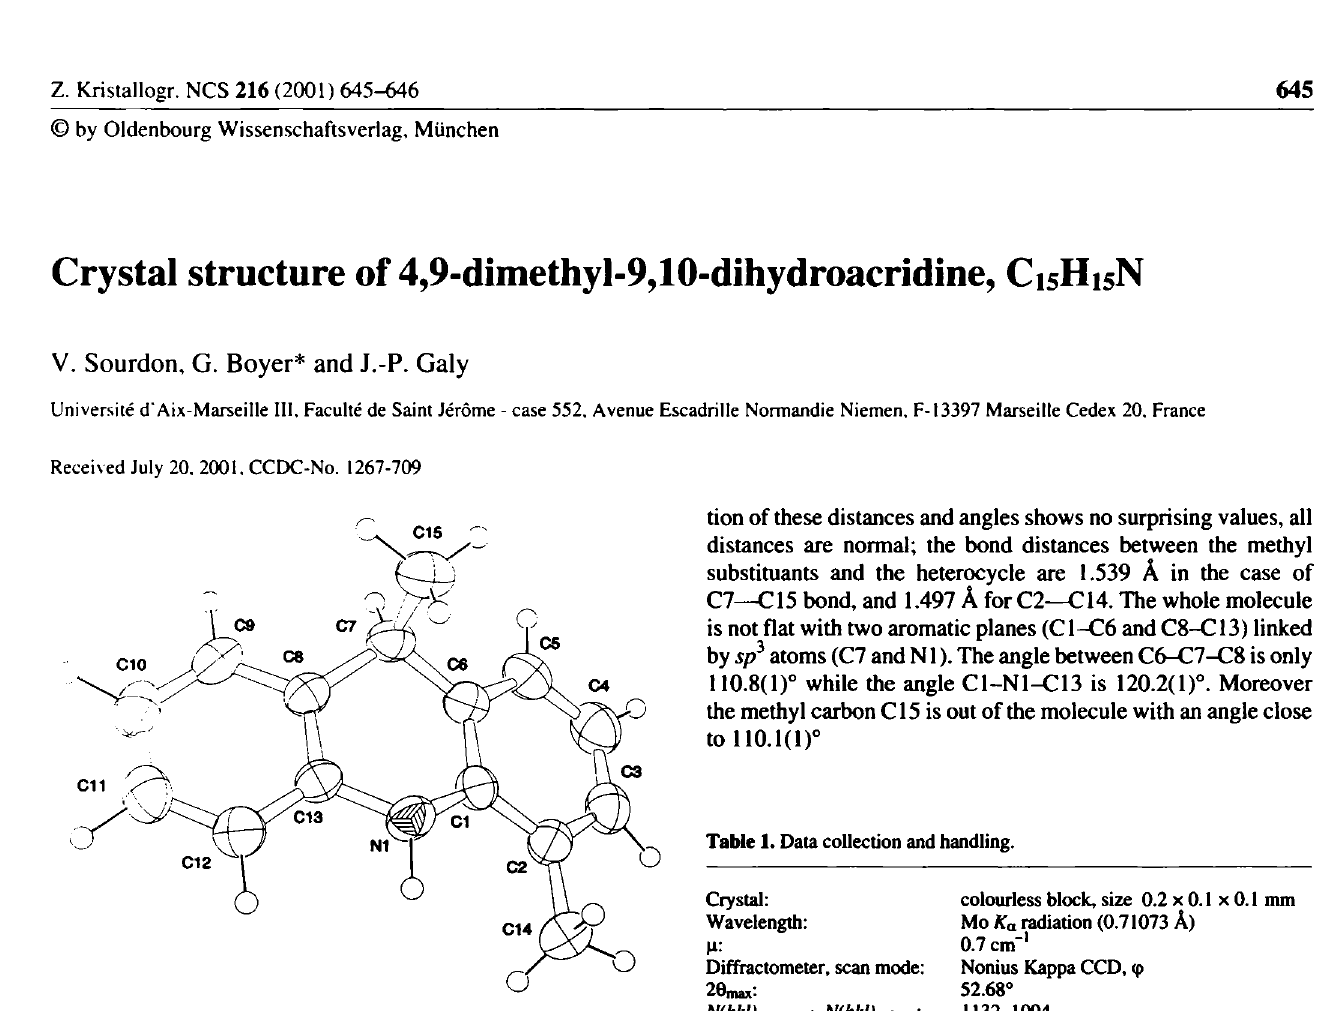
Table 2. Atomic coordinates and displacement parameters (in A 2